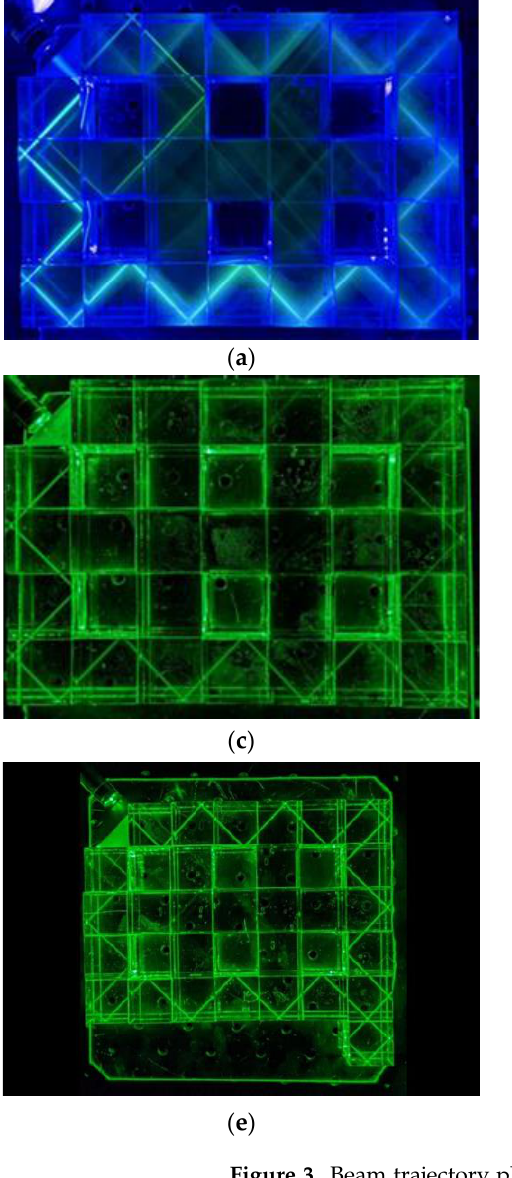
resonator size. To demonstrate this scalability, the rectangular prism resonators were made in two versions. The first set was manufactured from quartz glass with a refractive index of 1.43, with linear dimensions 12 × 12 × 8 mm 3 (Figure 4a). Their linear dimensions were ensured by the Maksutov method [23] with 10 um accuracy. The second set was manufactured from Chinese crown glass K9 with a refractive index of 1.517 and linear dimensions 30 × 30 × 30 mm 3 , with 30 um accuracy (Figure 4b).